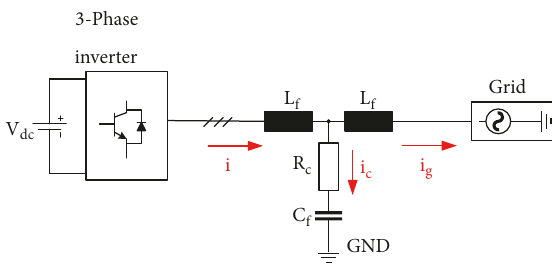
Figure 1: Block diagram of a two-level three-phase inverter with output LCL filter connected to the grid.